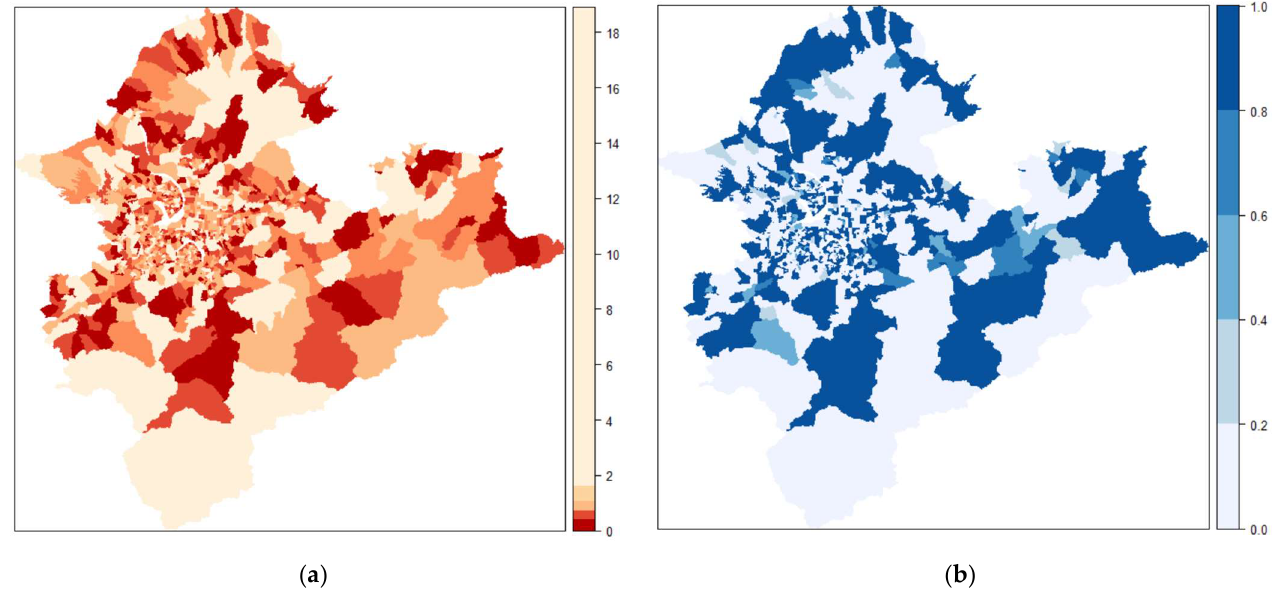
Figure 4. ( a ) Relative risks (RRs) of the Poisson spatial model on the supply counts of adult surgical masks; ( b ) the corresponding exceedance probability of undersupply: Pr (RR < 1)